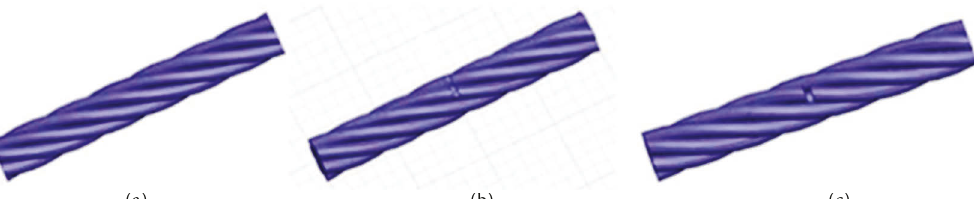
Figure 11: Three wire rope models with different degrees of damage.